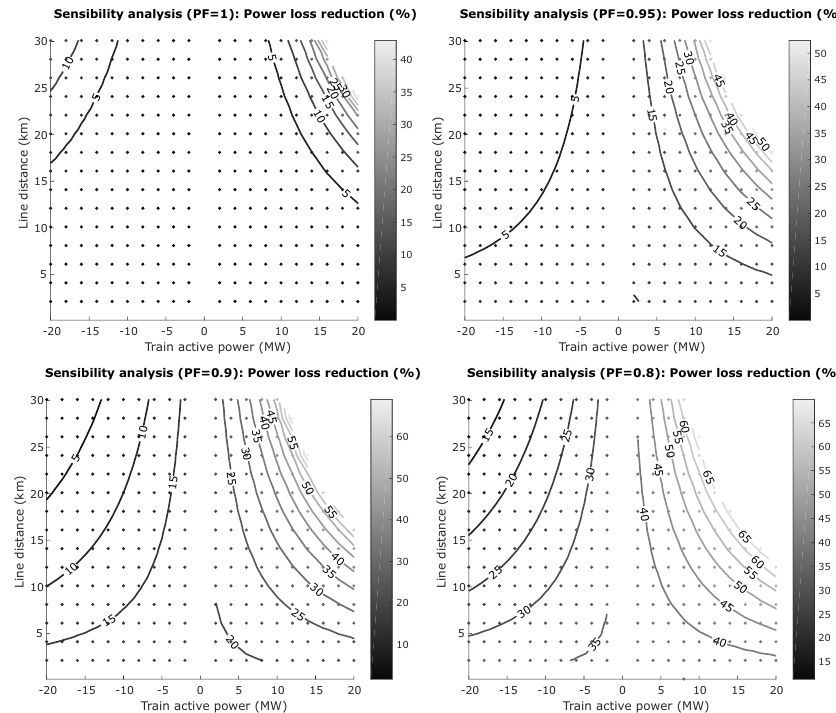
Figure 10. Sensibility analysis for reactive power compensation: line power loss reduction, in percentage, for different power factors. Note that the values near 0 MW or near 0 km are not relevant for this